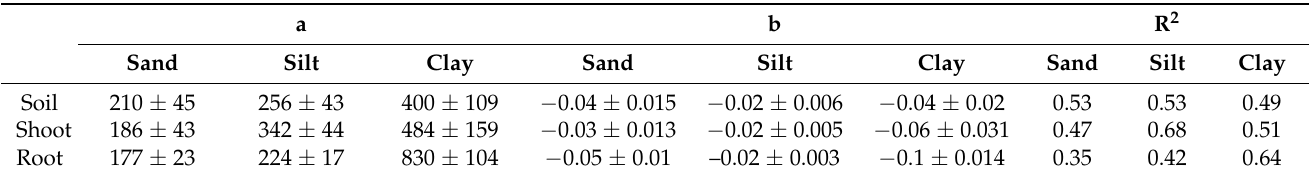
Figure 1. Carbon (mg C g soil − 1 day − 1 ) evolved from vetiver shoot and root decomposition in the three soils during 206 − days incubation period. Vetiver biomass was used from the glasshouse experiment and incubated at 25 ◦ C constant temperature. Plots show the raw data ( ◦ ), a fitted exponential model (–) and 95% confidence bands. Table 3. Rate of vetiver biomass (above and below ground biomass) decomposition (mg C g − 1 soil) in three soil textures (sand, silt and clay). Values of the intercept (a), the slope (b) and Coefficient of determination (R 2 ).